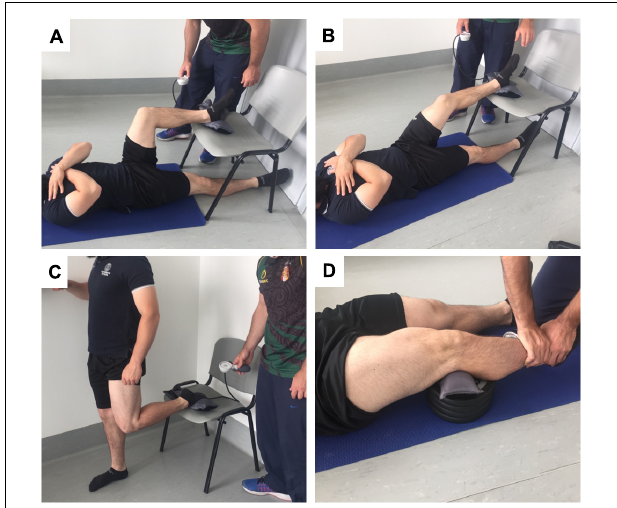
FIGURE 1 | Orientation for the assessment of hamstring and quadricep strength using the adapted sphygmomanometer test. Panel (A) is quadricep strength assessment at 90 ◦ of knee flexion, panel (B) is quadricep strength at 30 ◦ of knee flexion, panel (C) is hamstring strength assessment at 90 ◦ of knee flexion, panel (D) is hamstring strength at 30 ◦ of knee